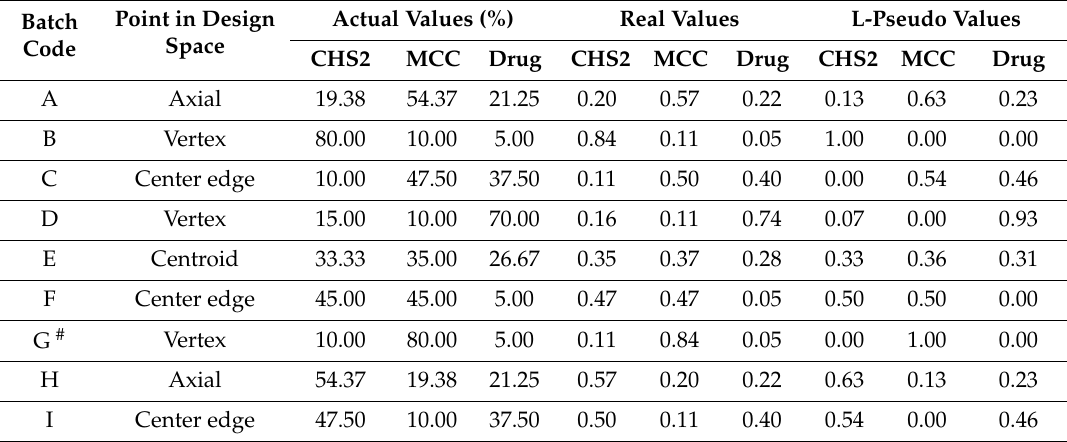
Table 1. Experimental mixture design for pellet batches. The design was applied to mini and conventional pellet batches